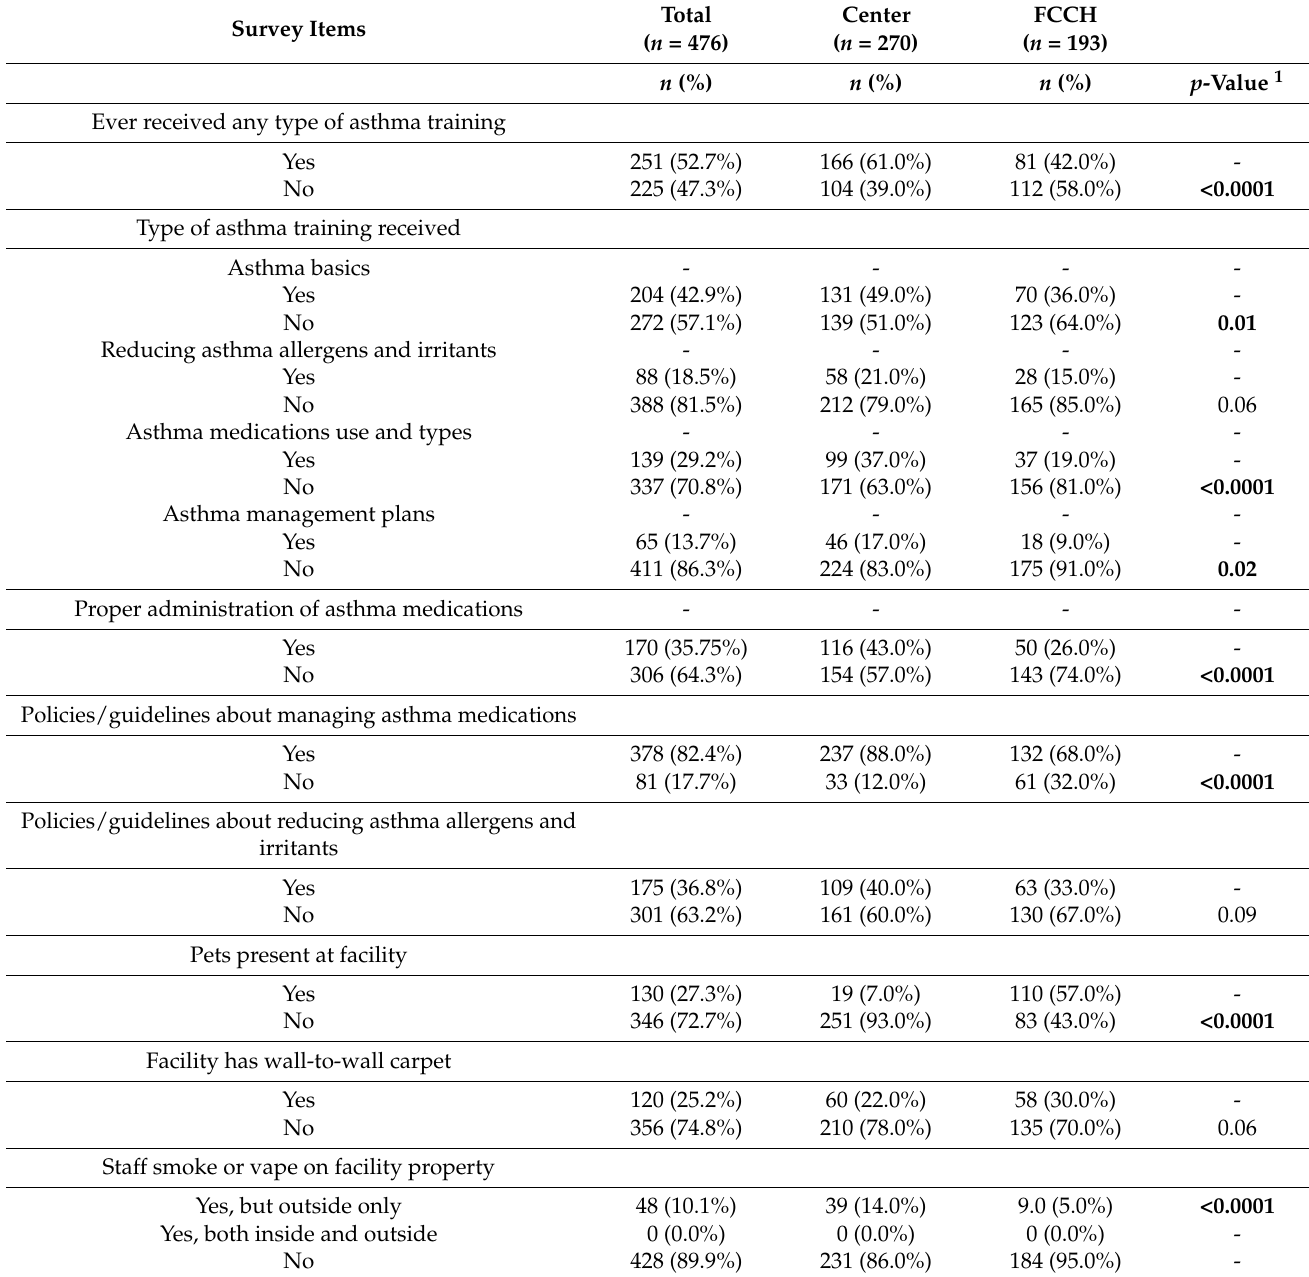
Table 2. Asthma-related training, policies, and practices reported for all early care and education programs, Centers, and family childcare homes (FCCHs), Oklahoma